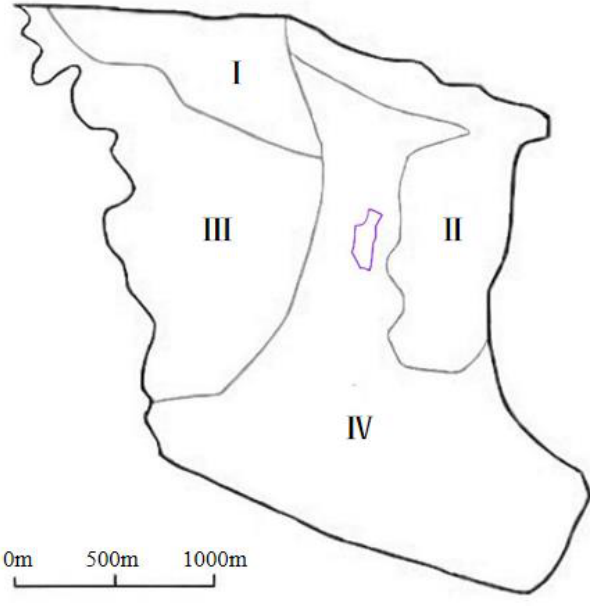
Figure 5. Parameter partition diagram of aquifer permeability coefficient.